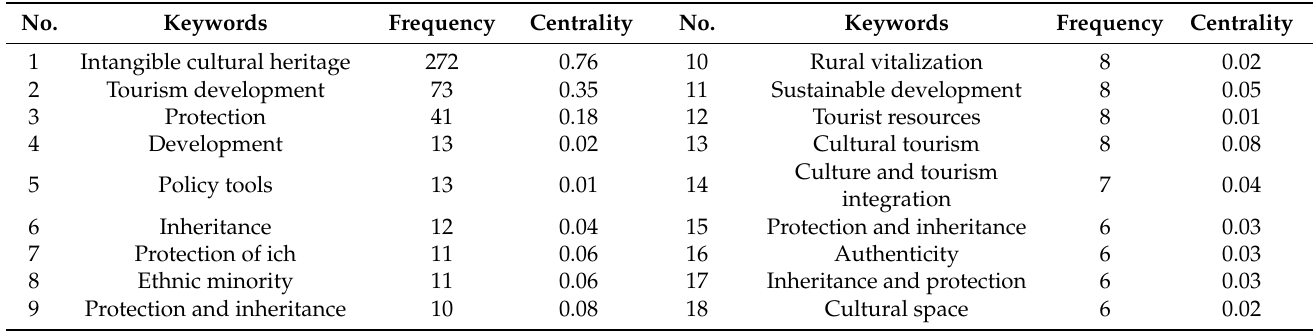
Table 1. Top 18 high-frequency keywords in Chinese journals.